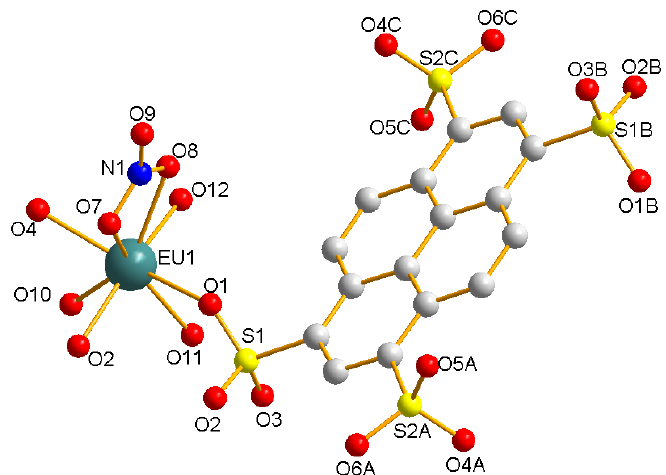
Figure 4. Coordination environment of the Eu(III) ions in compound 2 . Symmetry codes: (A) x, y, z − 1; (B) − x + 1, − y + 1, − z; (C) − x + 1, − y + 1, − z + 1 (the H atoms were omitted for clarity).